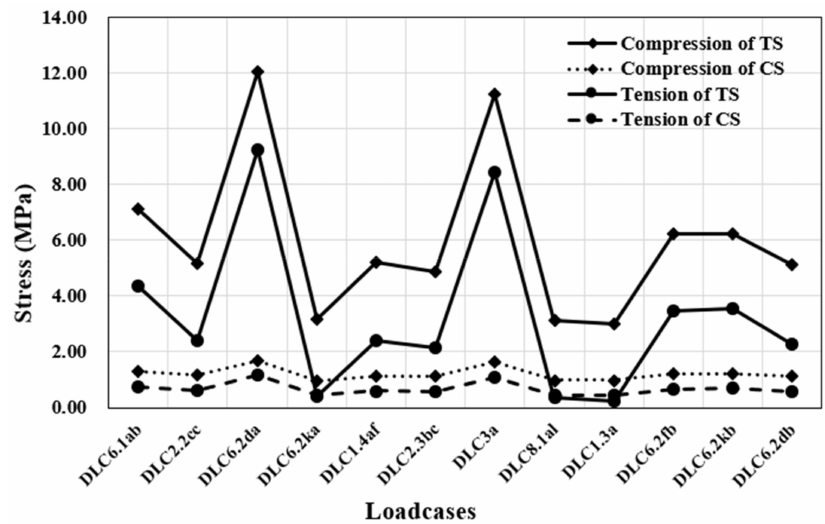
Figure 12. Maximum stresses in the concrete parts in each load case.